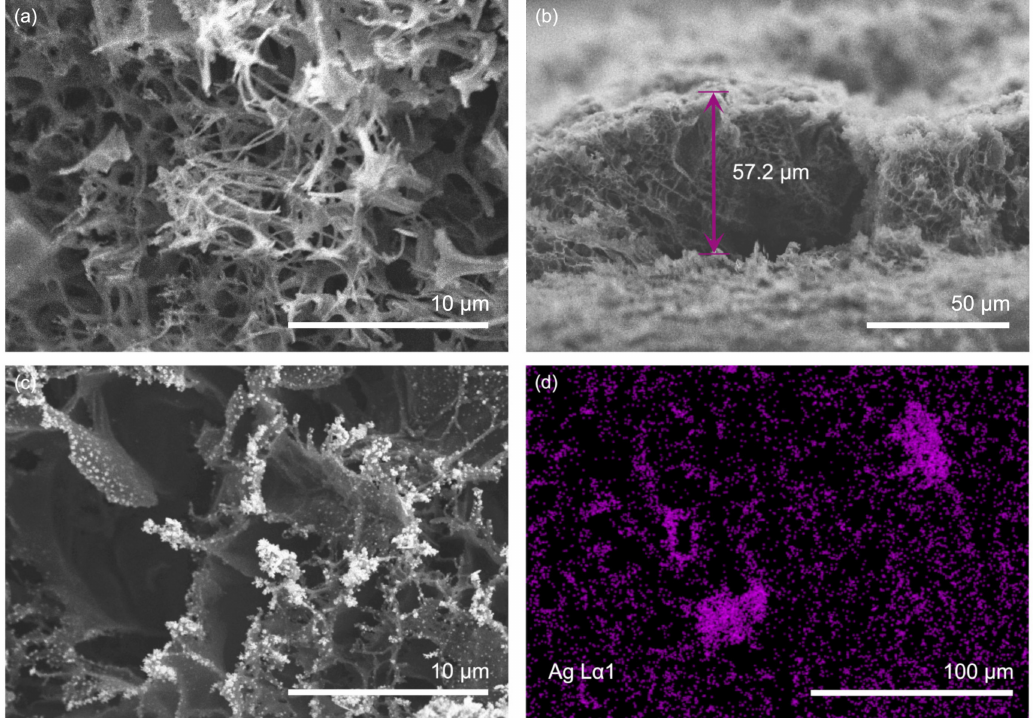
Figure 4. SEM micrographs: ( a ) top view of LIG; ( b ) cross-sectional view of LIG; ( c ) LIG/AgNPs; and ( d ) EDS mapping of